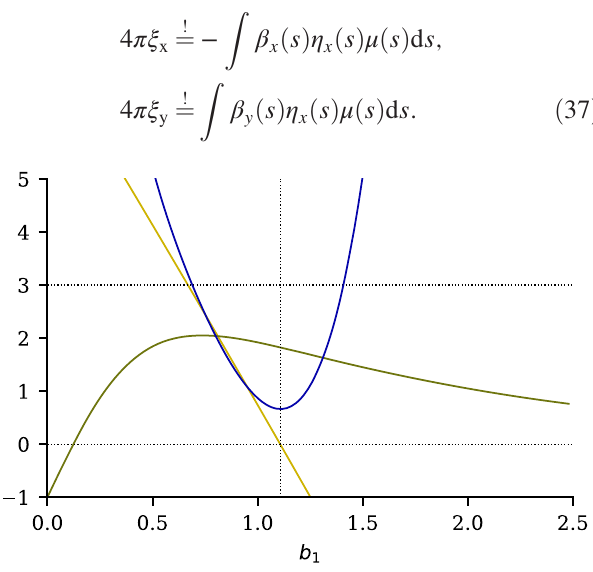
FIG. 5. TME emittance ratio F (blue), horizontal damping partition J (green) and momentum compaction integral I 1 x (yellow) in dependence of the dipole coefficient b 1 . The limits of J for stable motion, as well as the b 1 value used in the x example solution, are denoted with dashed lines.